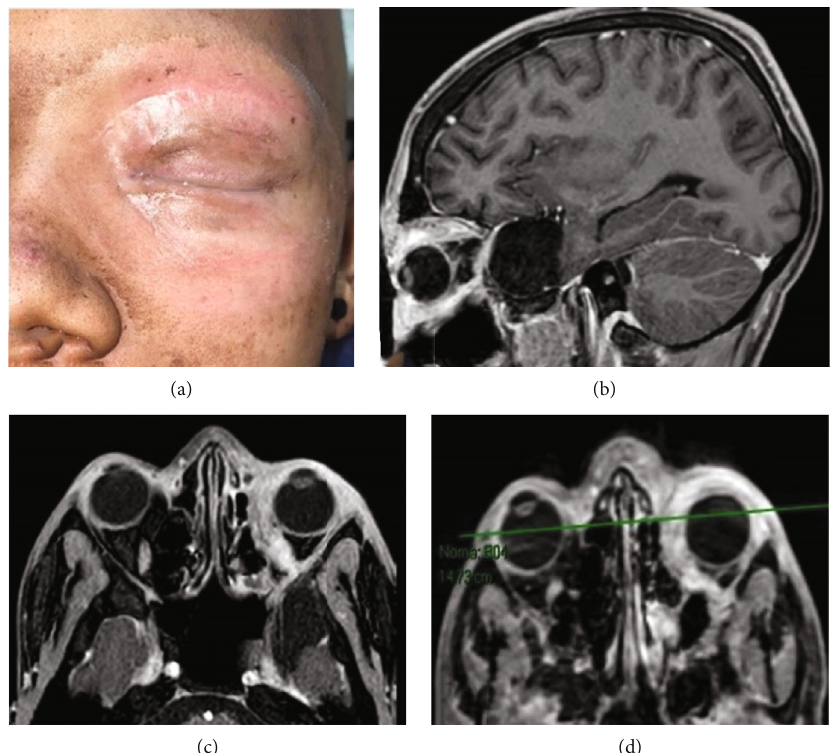
Figure 6: Clinical and imaging analyses after fi nal RT session. (a) Reduced tumor volume was observed and by MRI in sagittal (b) and axial (c, d) slices that showed complete response to treatment with LCR